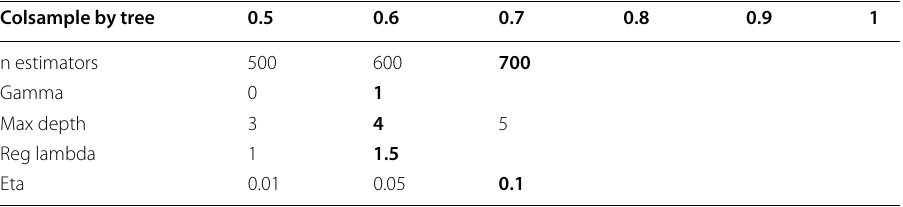
Table 10 XGBoost best parameter setting